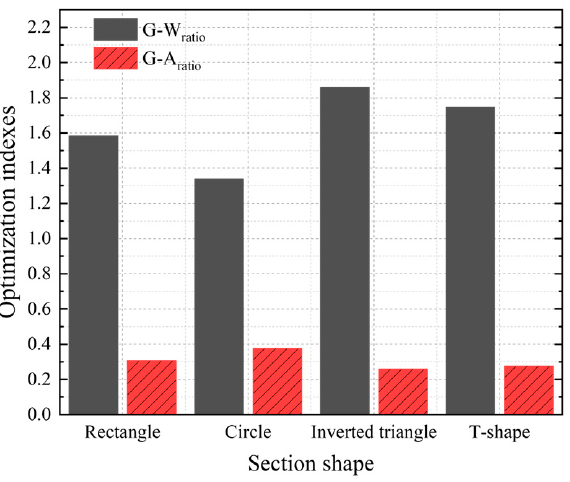
Figure 14. The variation in optimization indexes with different section shapes.